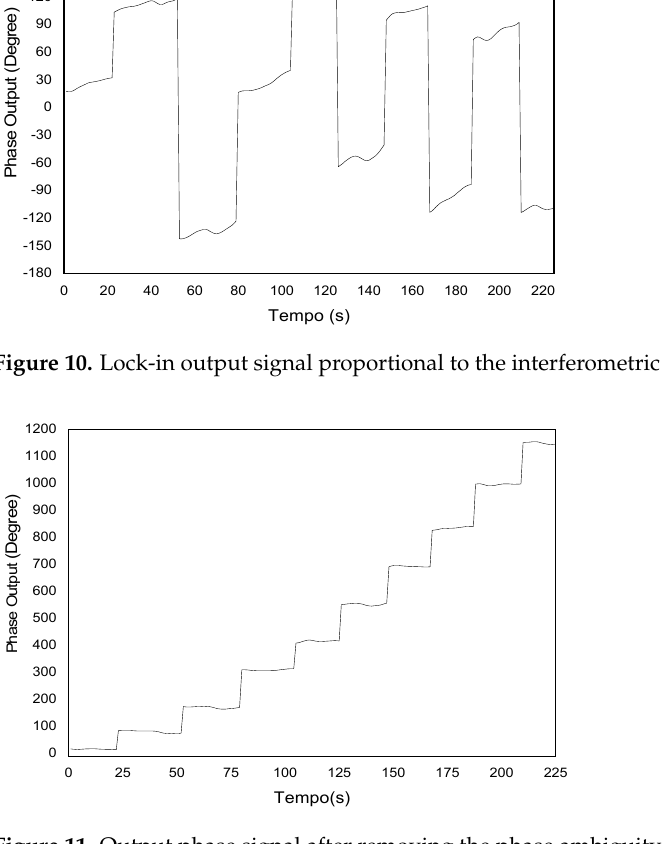
Figure 11. Output phase signal after removing the phase ambiguity.